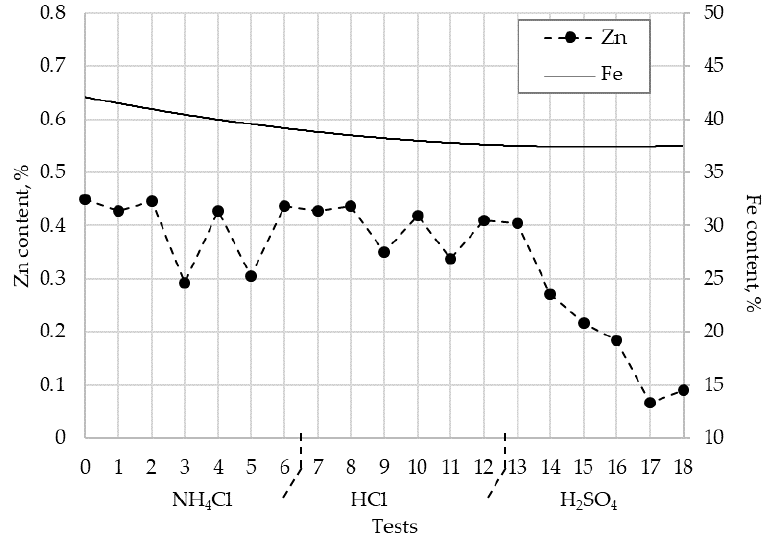
Figure 6. Zn and Fe content in blast furnace sludge at a di ff erent experimental test.